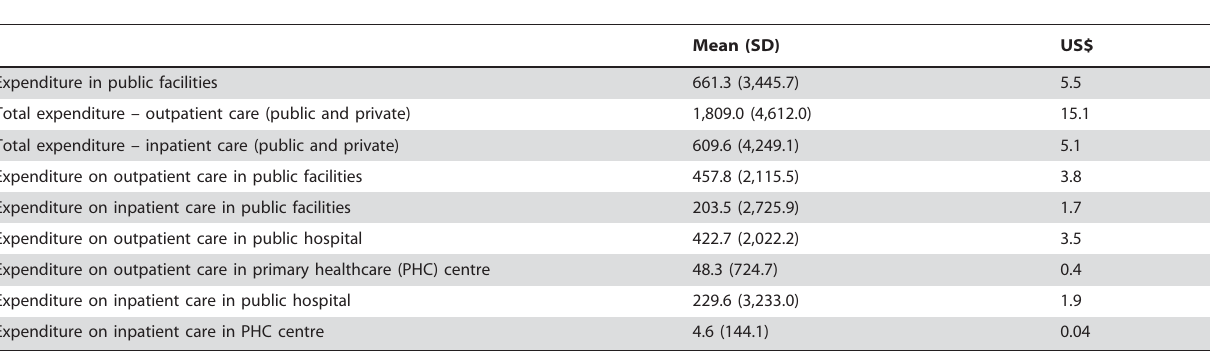
Table 1. Average monthly total household expenditures on outpatient and inpatient care and expenditure in public health